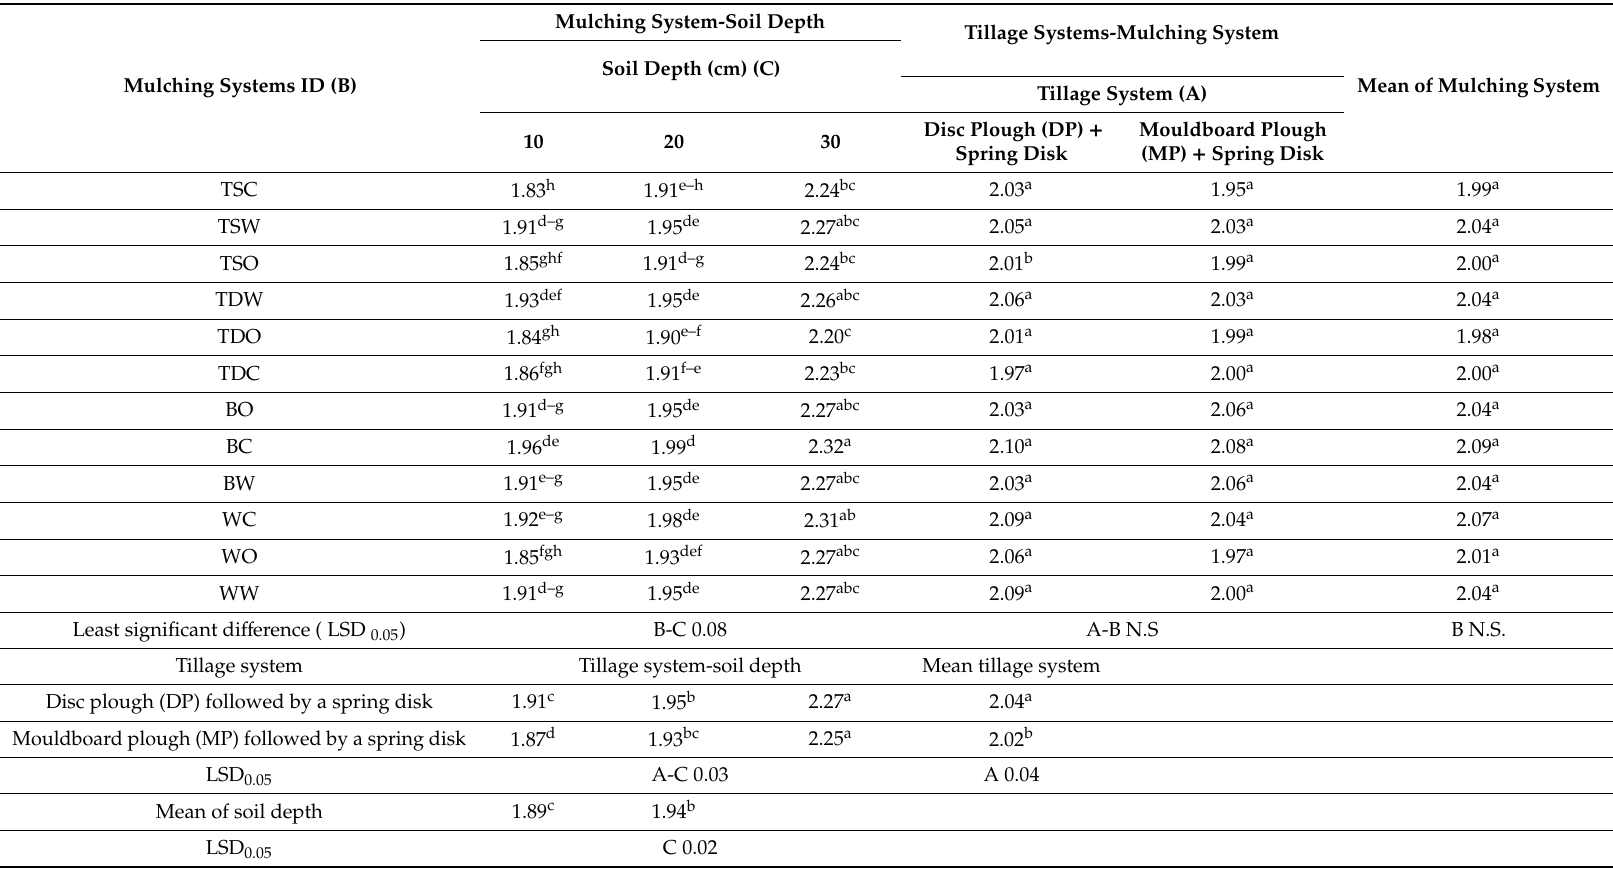
Table 3. Mean of the microwave penetration depths (M DP ) at various soil depths for the di ff erent soil